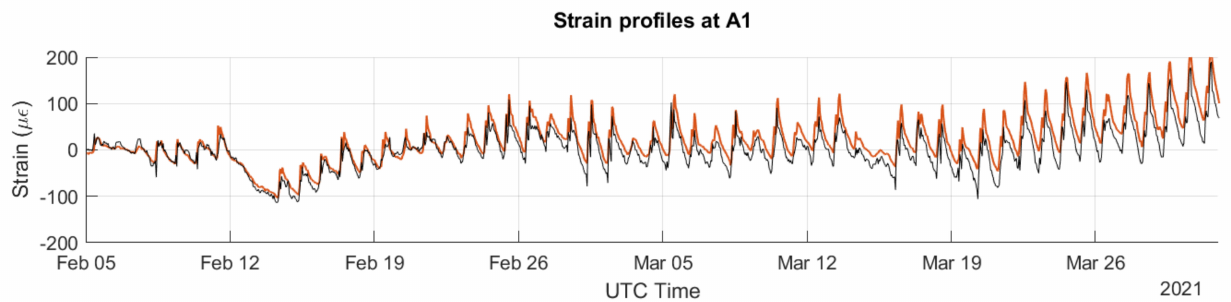
Figure 13. Comparison of the strain profile obtained respectively by the VW extensometer and the D-FOS strain cable at position A1 (from 5 February 2021 to 31 March 2021).